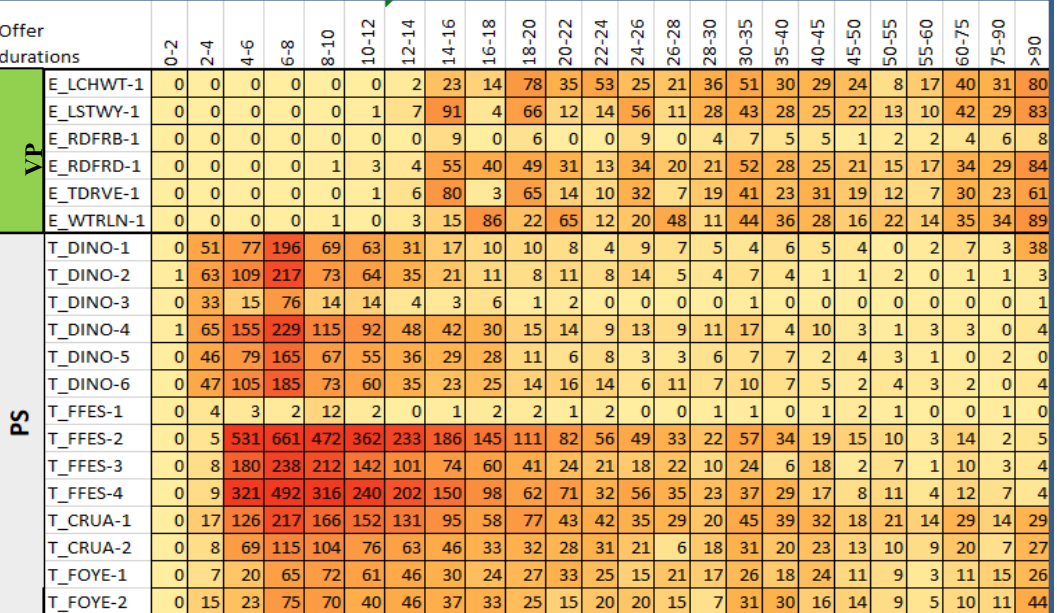
ff ers based on o ff ers’ duration [27]. Figure 1. Accepted offers based on offers’ duration [27]. Figure 1. Accepted o